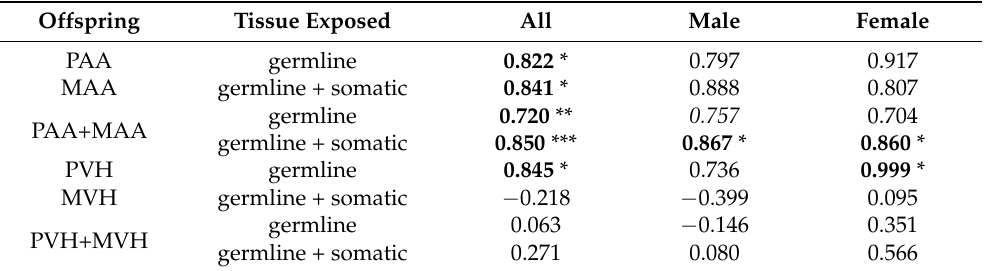
Table 1. Correlation between offspring body weight and AA or VH exposure across generations.